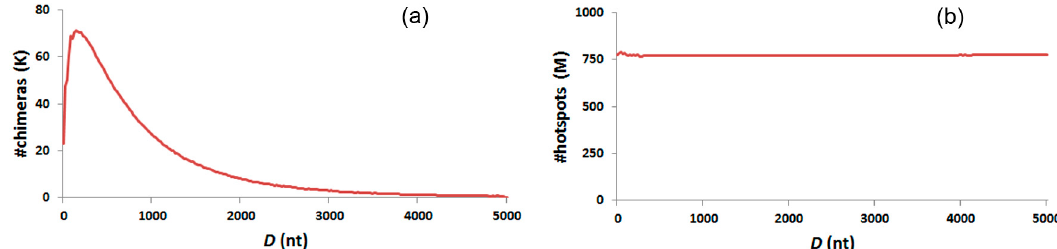
Figure 5. Chimera and chimeric hotspot distribution in distance of two segments. This scale takes 20 nt as one distance step. ( a ) Chimera distribution in distance of two segments; ( b ) Chimeric hotspot distribution in distance of two segments.